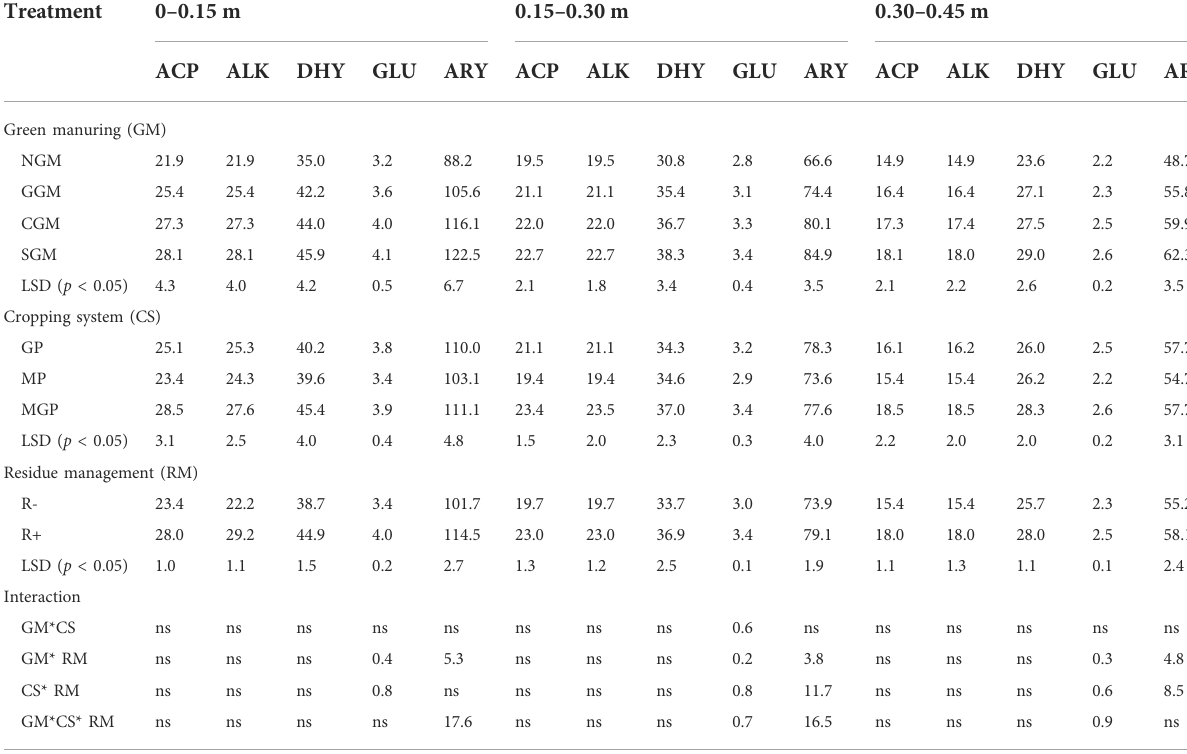
TABLE 1 Effect of green manuring, cropping systems, and residue management on soil enzymes in different soil depths after 5 years of experimentation.